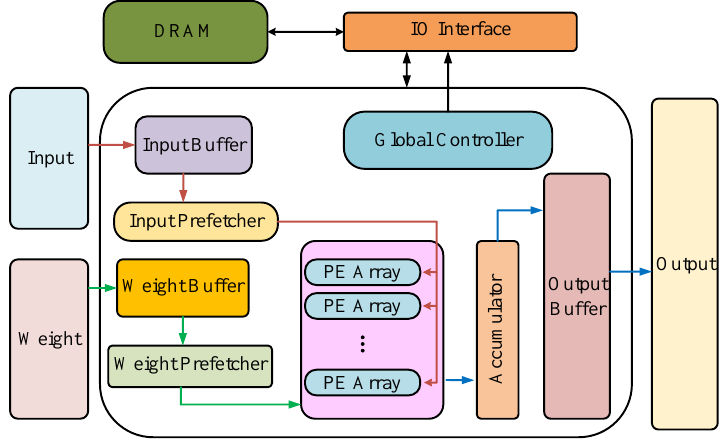
Figure 16. The GAN acceleration framework. Table 2. Performance comparison of different networks deployed using different optimization methods on different FPGA platforms in recent